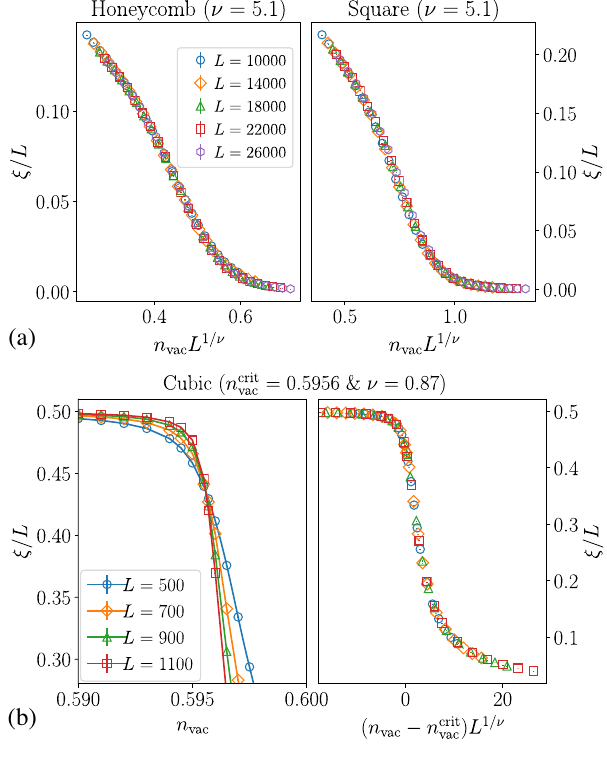
; L Þ , the correlation length corre- FIG. 13. (a) Data for ξ ð n vac sponding to the sample-averaged geometric correlation function C ð r − r 0 Þ of two-dimensional L × L samples at various values of n , collapse onto a single scaling curve when ξ =L is plotted as a vac L 1 = ν for small values of n function of n . (b) Left panel: same vac vac quantity on three-dimensional L × L × L cubic lattices, plotted as a function of n . Note that curves corresponding to different L vac ≈ 0 . 6 . display a sharp crossing at a threshold n crit near n vac vac (b) Right panel: data for ξ =L from L × L × L cubic lattices collapse onto a single scaling curve in the vicinity of this threshold when plotted as a function of the scaling variable ð n − n crit Þ L 1 = ν . See Sec. VII for details. vac vac